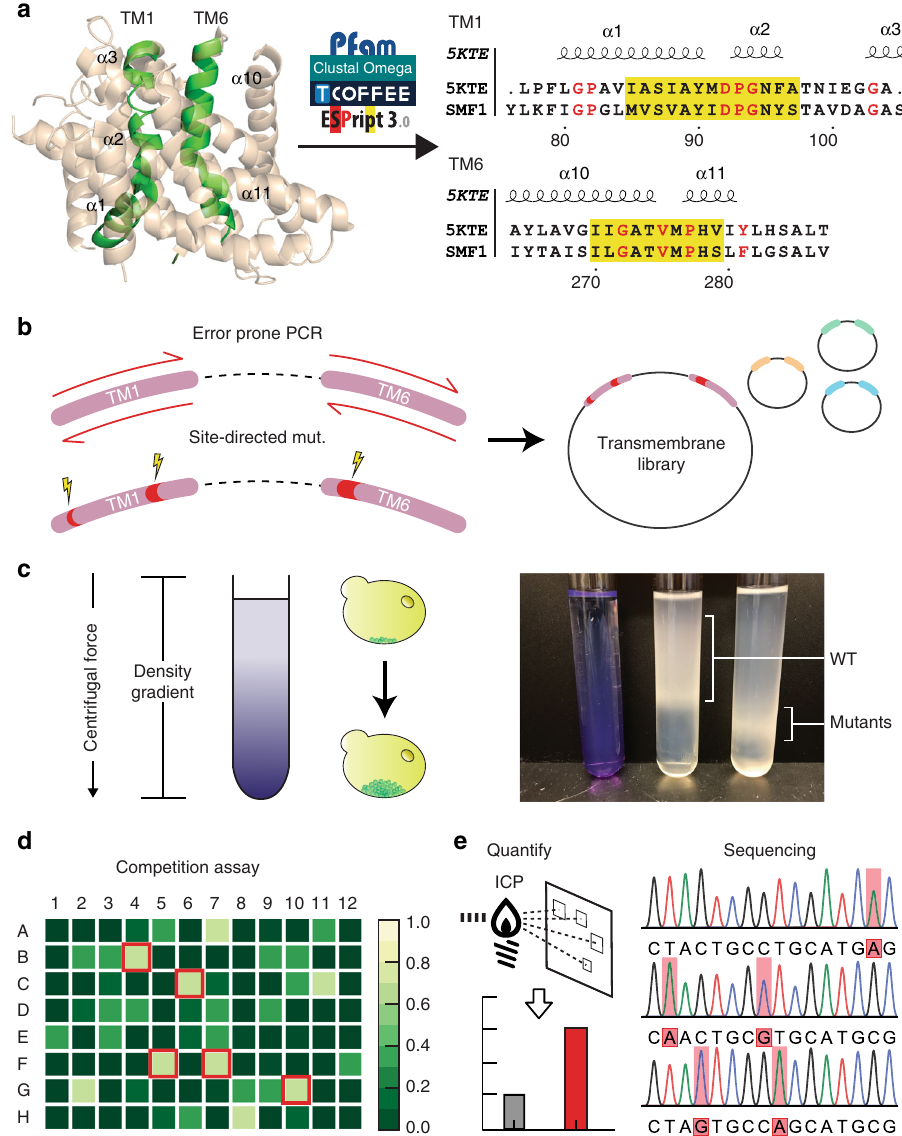
Fig. 4 A developed high throughput screen to systematically engineer selective metal transporters. a Pfam protein database and clustering services such as Clustal Ω , TCoffee, and ESpript3 were used to align SMF1 with referenced protein crystal structure 5KTE 33 . Through literature searches and multi-alignments, transmembrane 1 and 6 (TM1, 6) were found to be the most signi fi cant regions for mutagenesis. The alignment comparing 5KTE with SMF1 shows the TM1 and TM6 region, where yellow highlights indicate conserved regions, and red text indicate highly conserved residues (similarity score > 0.7). b Mutations cited to enhance or decrease metal transport were selectively mutated using site-directed mutagenesis. Libraries were then generated on top of these mutations through error-prone PCR. c An initial screen was performed through rate-zonal density gradient centrifugation. d , e Fractionated layers were plated, picked, and assayed for metal uptake. A competition assay of the desired metal versus the native metal (e.g., manganese) was performed calorimetrically ( d ). Wells with the least amount of native metal uptake (highest signal) were selected and ( e ) quantitatively measured for metal uptake using ICP. Mutations were sequenced and reintroduced in the pipeline to generate better performing